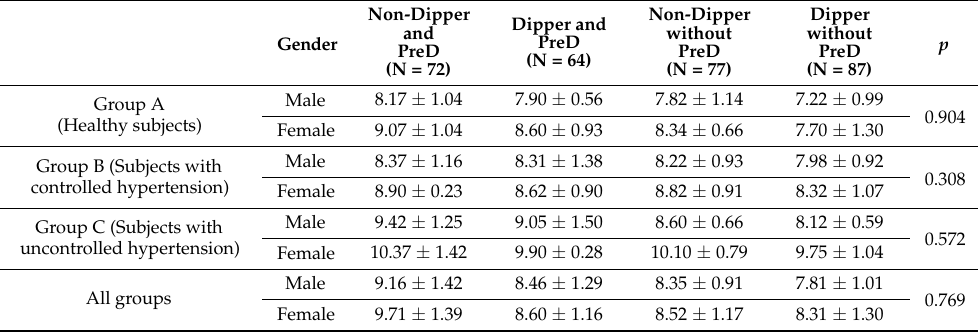
Figure 2. Pulse wave velocity (PWV) values among three age groups and genders depending on dipping profile and the presence of prediabetes (F = 0.86, p = 0.527 for all; F = 21.38, p < 0.001 for dipper and prediabetes groups). Table 3. Hypertension groups and PWV values depending on dipping status, prediabetes (PreD) and gender. Values represent means ± standard deviation and were analyzed by one-way ANOVA divided by